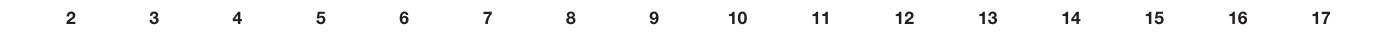
TABLE 1 | Descriptive statistics and correlation analysis of each variable.